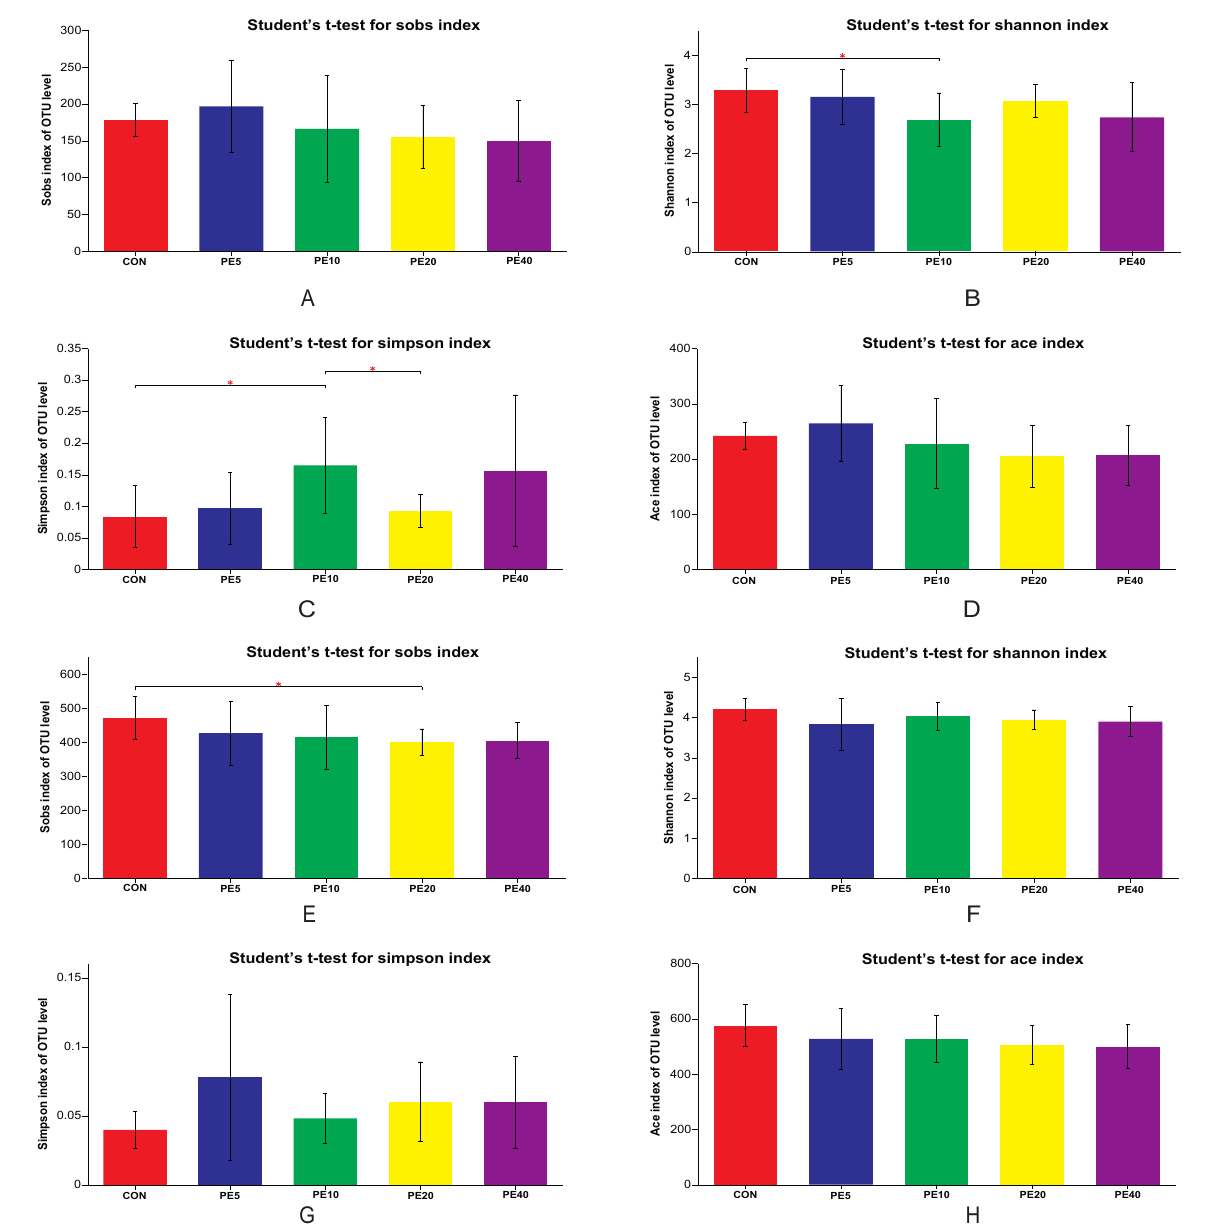
Figure 2. Fecal bacterial diversity of calves supplemented with Amla ( Phyllanthus emblica ) whole-fruit powder at 28 ( A – D ) and 75 ( E – H ) days of age. CON, PE5, PE10, PE20, and PE40 indicate control (0), 5, 10, 20, and 40 g/d/head supplementation of Amla fruit powder, respectively. Significant differences are marked as * 0.01 < p ≤